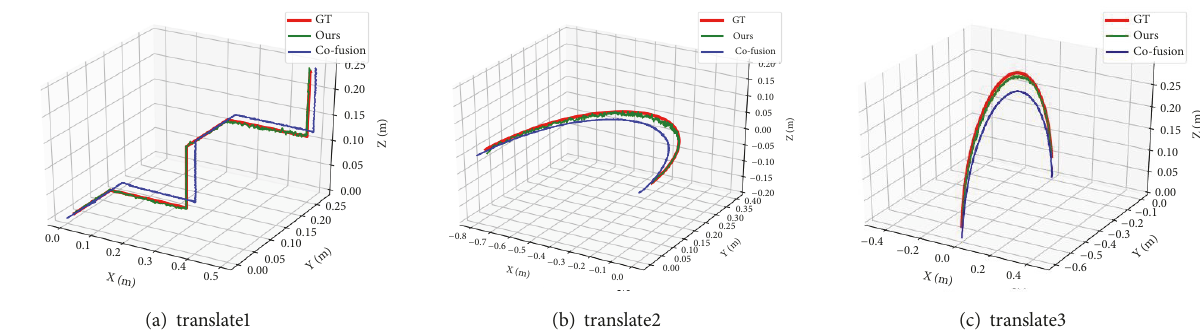
Figure 6: Comparison between the ground truth, our estimated trajectory, and Co-fusion’s estimated trajectory on the translate